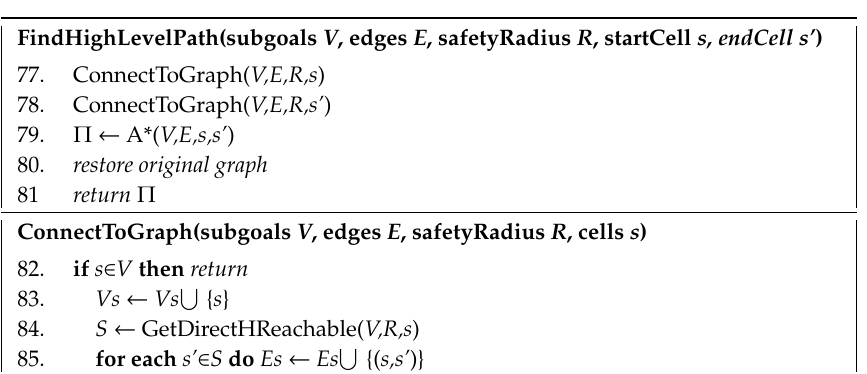
Table 5. The pseudocode for searching paths in DM-based subgoal